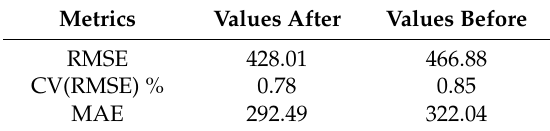
Table 3. Performance metrics of best model after feature selection & hyperparameter tuning.